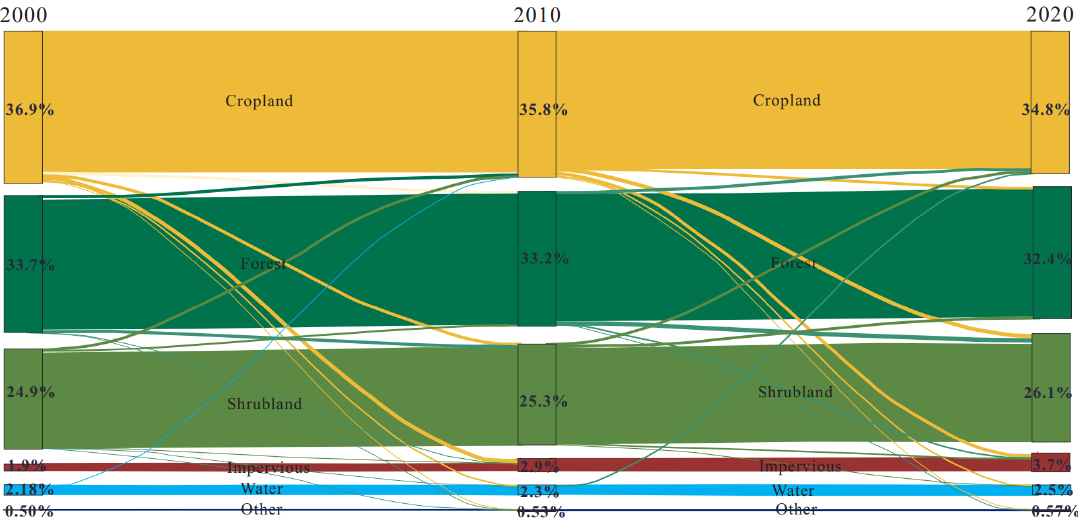
Figure 4. LULC transition plot in Vietnam during 2000–2020.